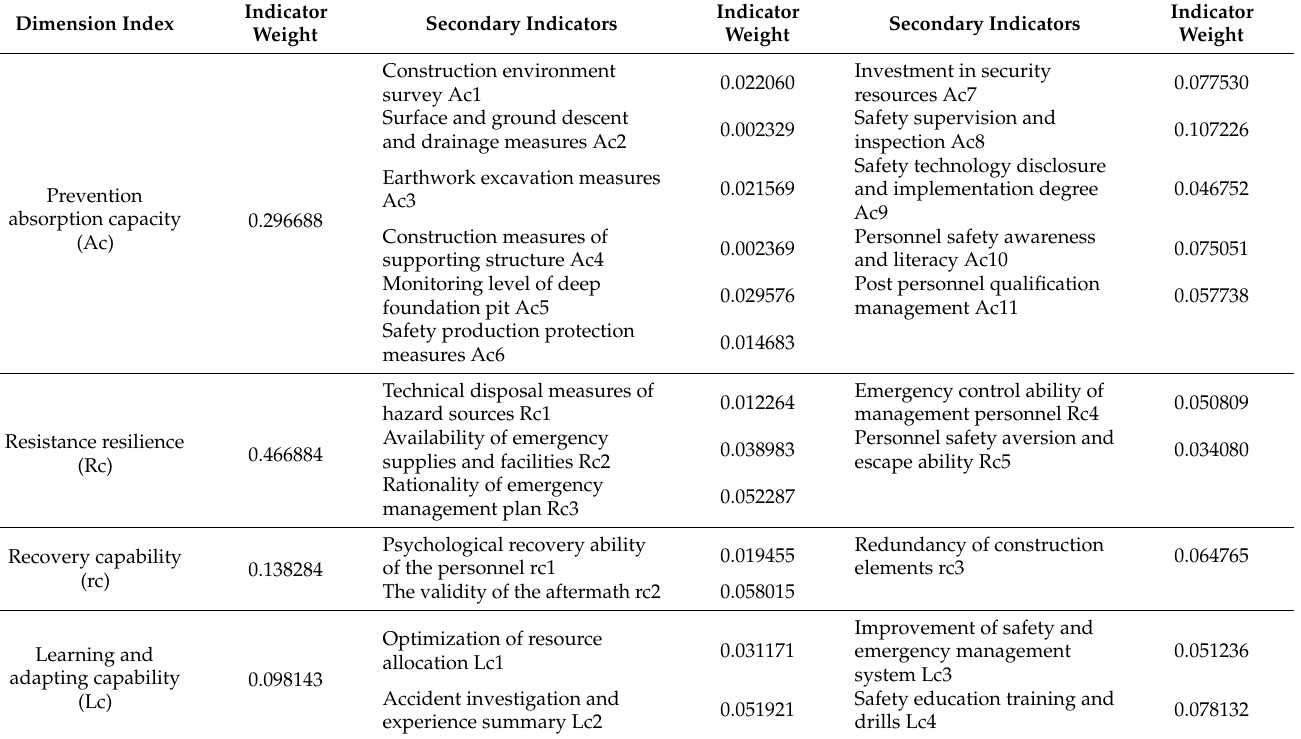
Table 6. Evaluation index weight of resilience of deep foundation pit construction safety